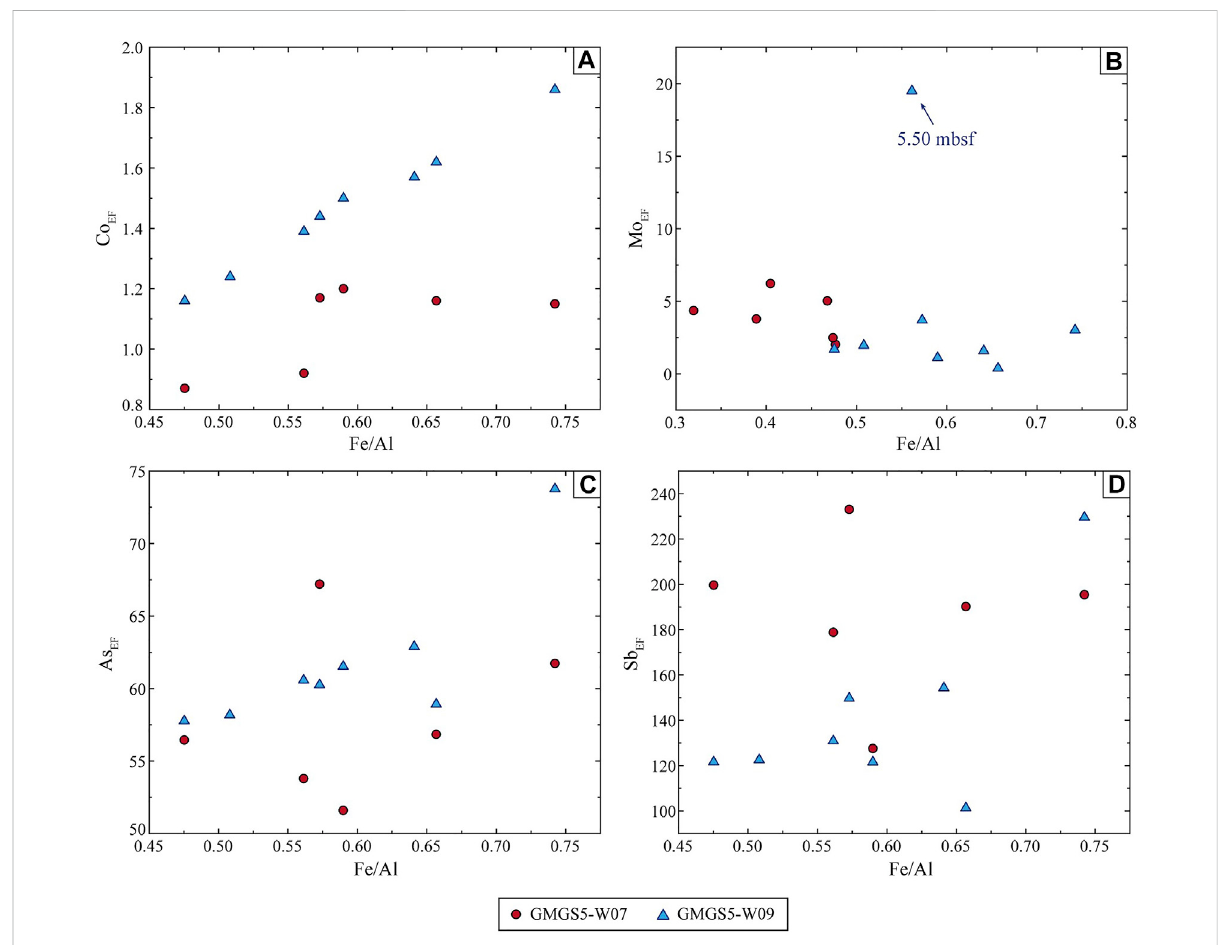
FIGURE 8 Trace elements patterns. (A) Co EF vs. Fe/Al, (B) Mo EF vs. Fe/Al, (C) As EF vs. Fe/Al, and (D) Sb EF vs. Fe/Al ratios for sediment samples. The enrichment factor (EF) was calculated as X EF = [(X/Al) sample /(X/Al) average ], and the samples were normalized using Earth ’ s upper crust compositions (McLennan,